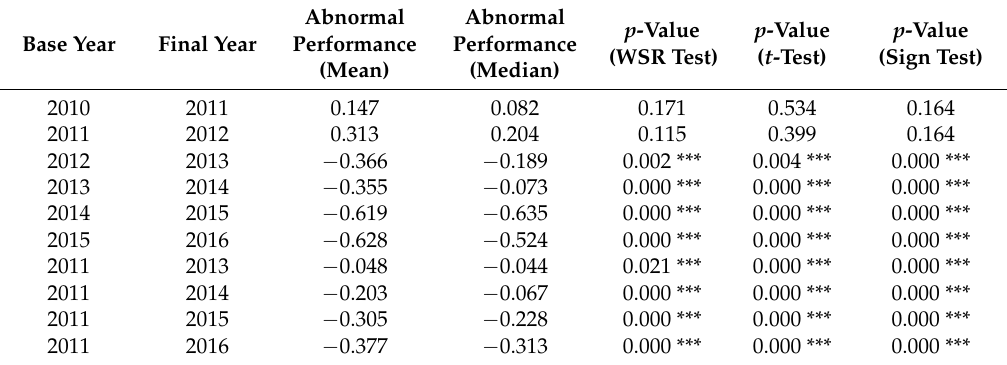
Table 2. Abnormal performance in market valuation, matched by ROA and